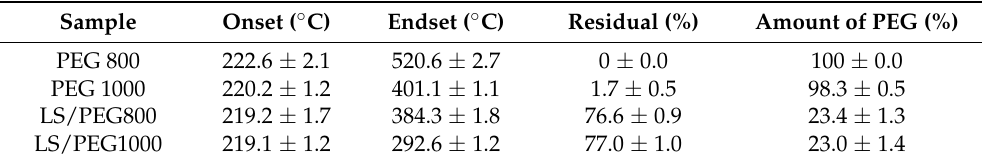
Figure 3. TGA experiments performed on ( a ) pure PEG 800 and LS/PEG800; ( b ) pure PEG 1000 and LS/PEG1000. Table 4. Results of TGA experiments performed on PEG 800 and PEG 1000 and their PCM-stone composites. TGA data of PEG 1000 and LS/PEG1000 have been measured in [31]. (Onset and Endset represent the initial and final temperatures of the degradation process, respectively).